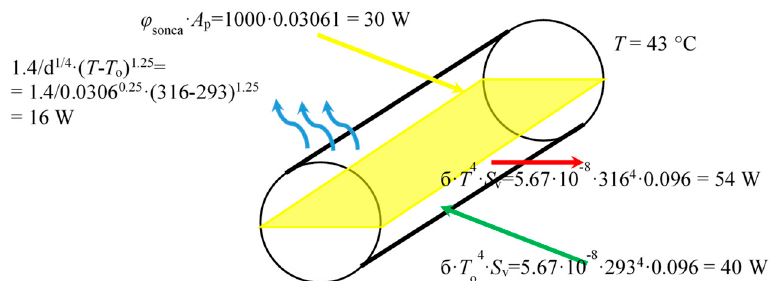
Figure 4. Thermal balance of the cylinder in the sun, taking convection into account. Note: sun = 30 W, surrounding = 40 W, convection = 16 W, conductor at 43 °C = 54 W.